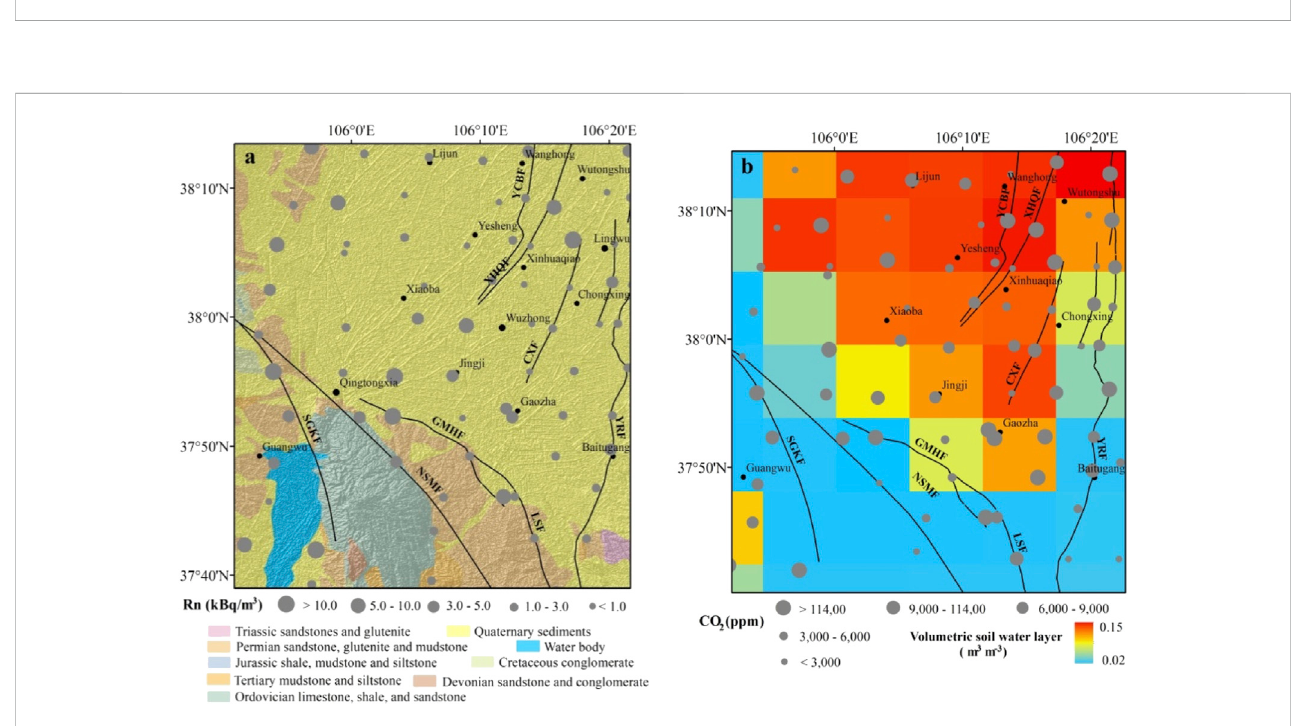
FIGURE 5 (A) Lithology and (B) local variance of surface latent heat fl ux in the Wuzhong – Lingwu